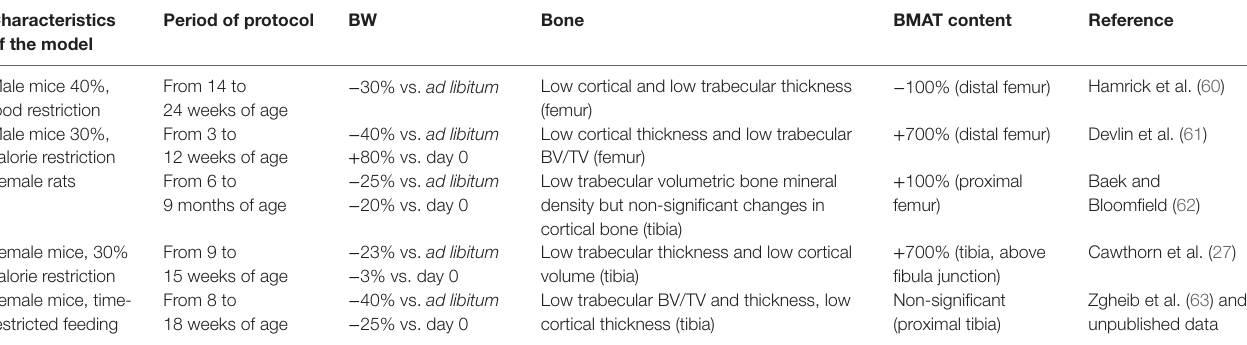
characteristics of the